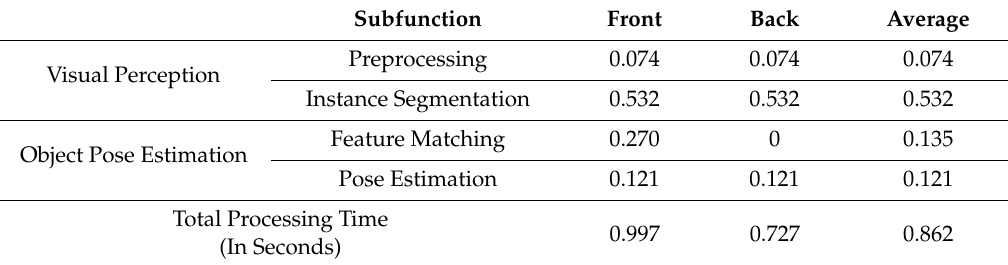
Table 8. Average processing time in each step of the proposed method.